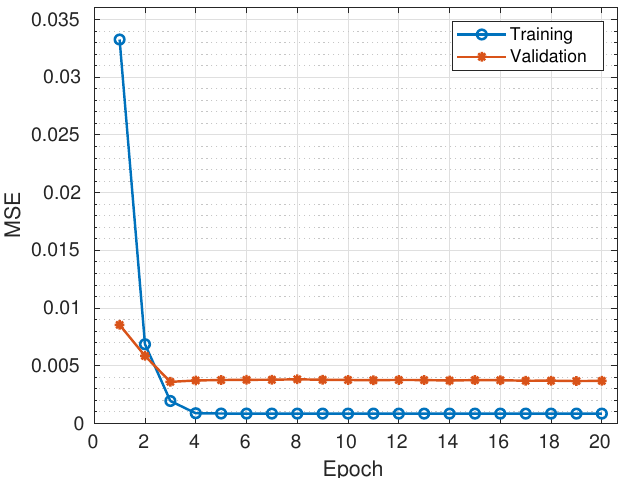
Figure 7. Reconstruction losses of LAE